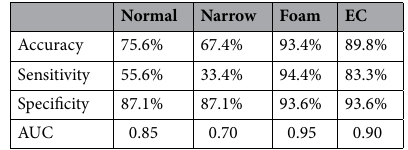
Table 1. Performance of RF classifiers in 4 different conditions. AUC area under the curve of receiving operator